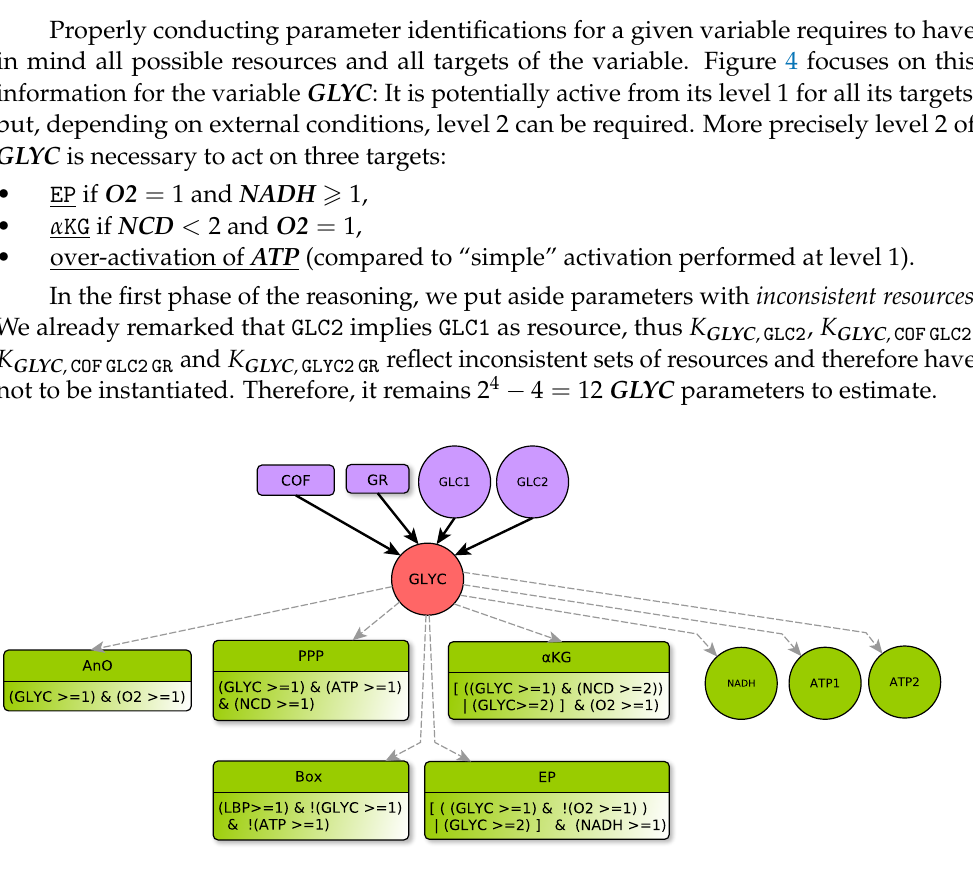
Figure 4. Resources and targets of the glycolysis